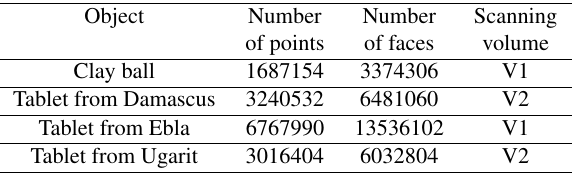
Table 6: Characteristics of 3D model geometry reconstructed with the ScanRider 1.2 scanner for the four replicas